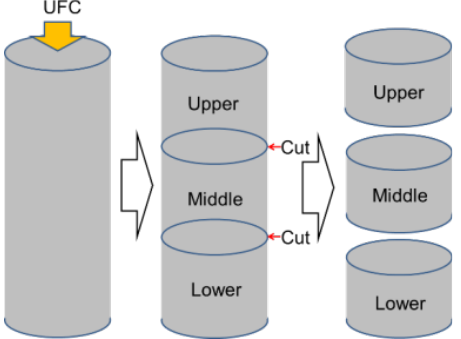
Figure 25. Examination of steel-fibre segregation.